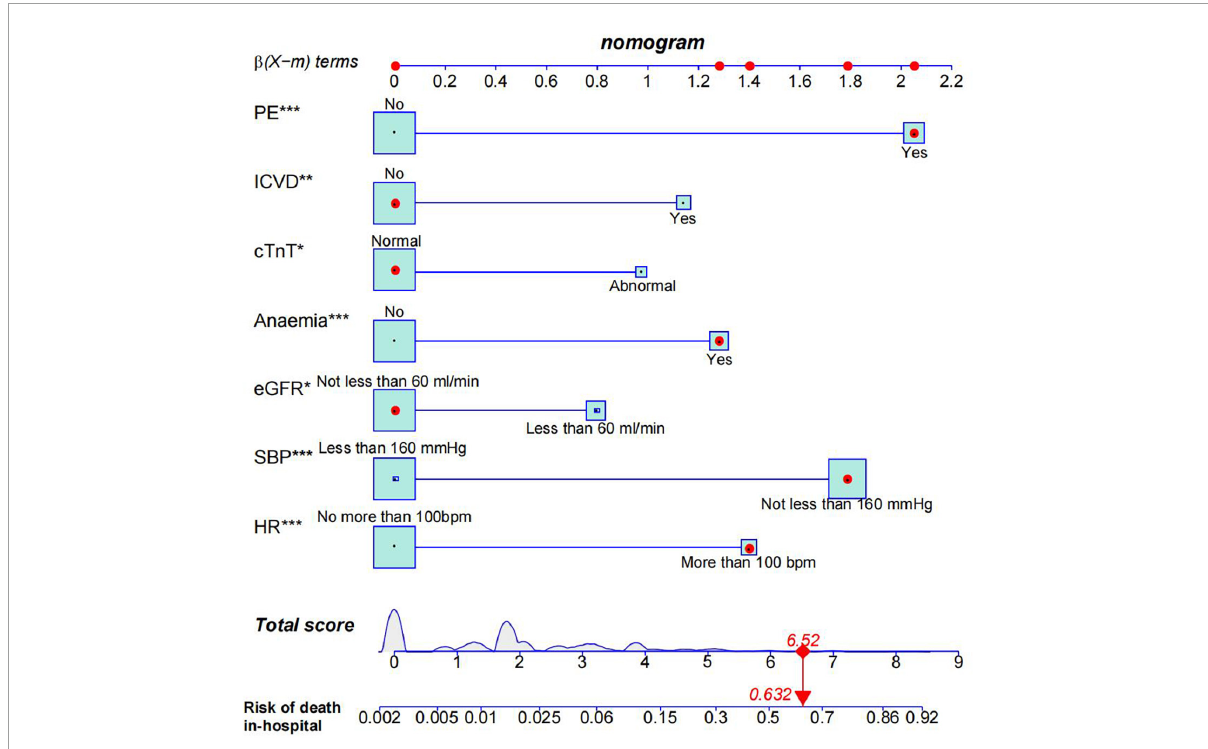
FIGURE4 Nomogram model predicts in-hospital death risk in patients with Stanford type B aortic dissection. Given values of the seven variables, the patient can be mapped onto the nomogram. Each red dot represents the value of each variable of the patient. As shown, a probability of 63.2% was the risk of in-hospital death in this type B aortic dissection patient. PE, pleural effusion; ICVD, ischemic cerebrovascular disease; HR, heart rate. *0.01 = p < 0.05; **0.001 = p < 0.05; *** p <